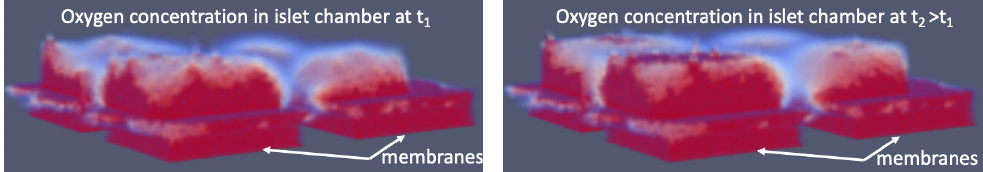
Figure 10. Oxygen concentration at the membranes (inlet) and within the islet chamber for two different times t 1 and t 2 > t 1 as the initial oxygen front convected with the flow enters the bioartificial pancreas. Red denotes high concentration and white and blue low concentration. The flow is from bottom to top. We can see that the regions on the left in both pictures, which are closest to the outlet, get more oxygen than the regions on the